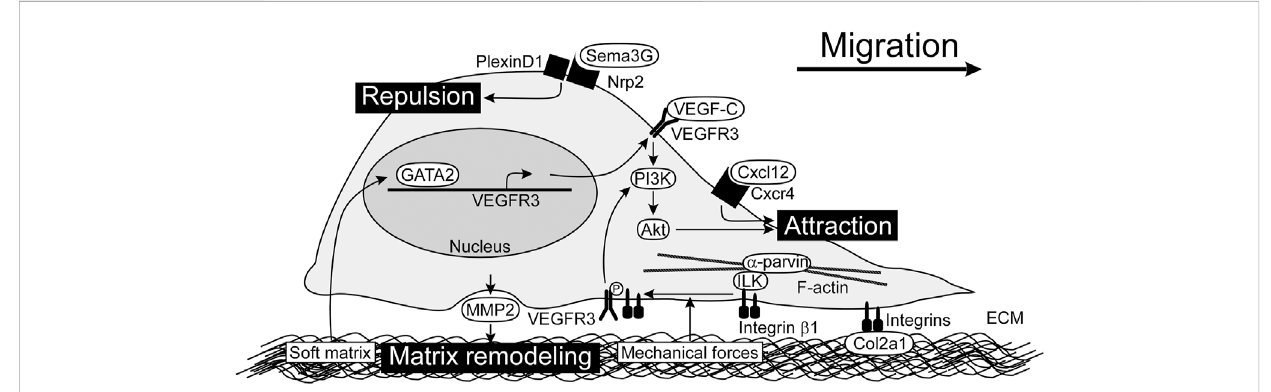
FIGURE 1 Chemotactic factors and LEC-ECM interactions for LEC migration. VEGF-C/VEGFR3/PI3K/Akt pathway is the main signaling for LEC migration. Cxcl12 also promotes LEC migration. Sema3G serves as a repulsive factor which acts through Nrp2/PlexinD1 receptor complex. Integrins expressed by LECs play a crucial role in adhesion to ECM as well as modulation of VEGFR3 signals. By sensing mechanical forces, integrin β 1 is released from ILK and interacts with VEGFR3. MMP2 produced by LECs perform matrix remodeling, possibly modulating matrix stiffness. Soft matrix induces GATA2 expression, which enhances VEGFR3 expression. ECM, extracellular matrix; ILK, integrin-linked kinase; LEC, lymphatic endothelial cell; MMP2, matrix metalloproteinase 2; Nrp2, neuropilin-2; PI3K, phosphoinositide 3-kinase; Sema3G, Semaphorin 3G; VEGF-C, vascular endothelial growth factor C; VEGFR3, vascular endothelial growth factor receptor